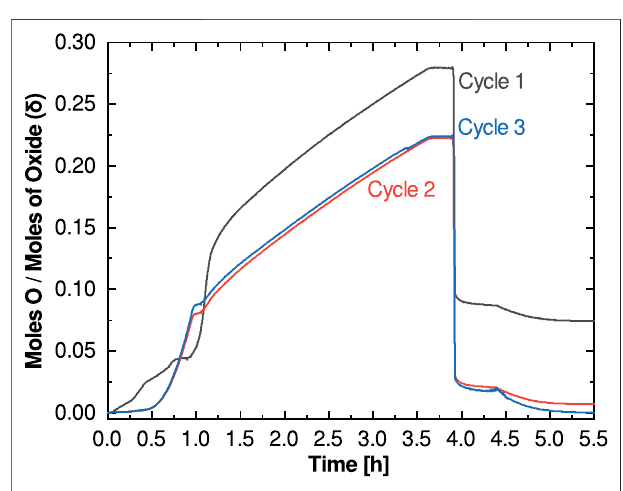
FIGURE3| CyclesofTPTRinBCM(Barcellosetal.,2018).adaptedand used by permission of The Royal Society of